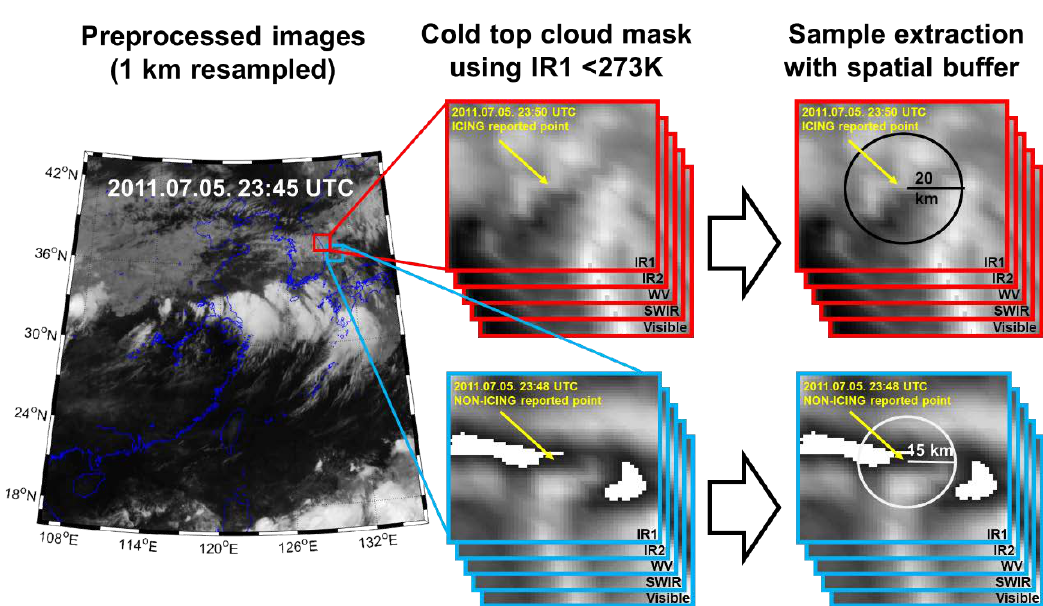
Figure 2. An example of icing and non-icing sample extraction from COMS data. Preprocessed images are masked using the threshold at the infrared-1 (IR1) channel and a spatial buffer. In this example, icing was reported on 5 July 2011 23:50 UTC at N37.42° and E129.2° and non-icing was reported on 5 July 2011 23:48 UTC at N36.58° and E130.25°.